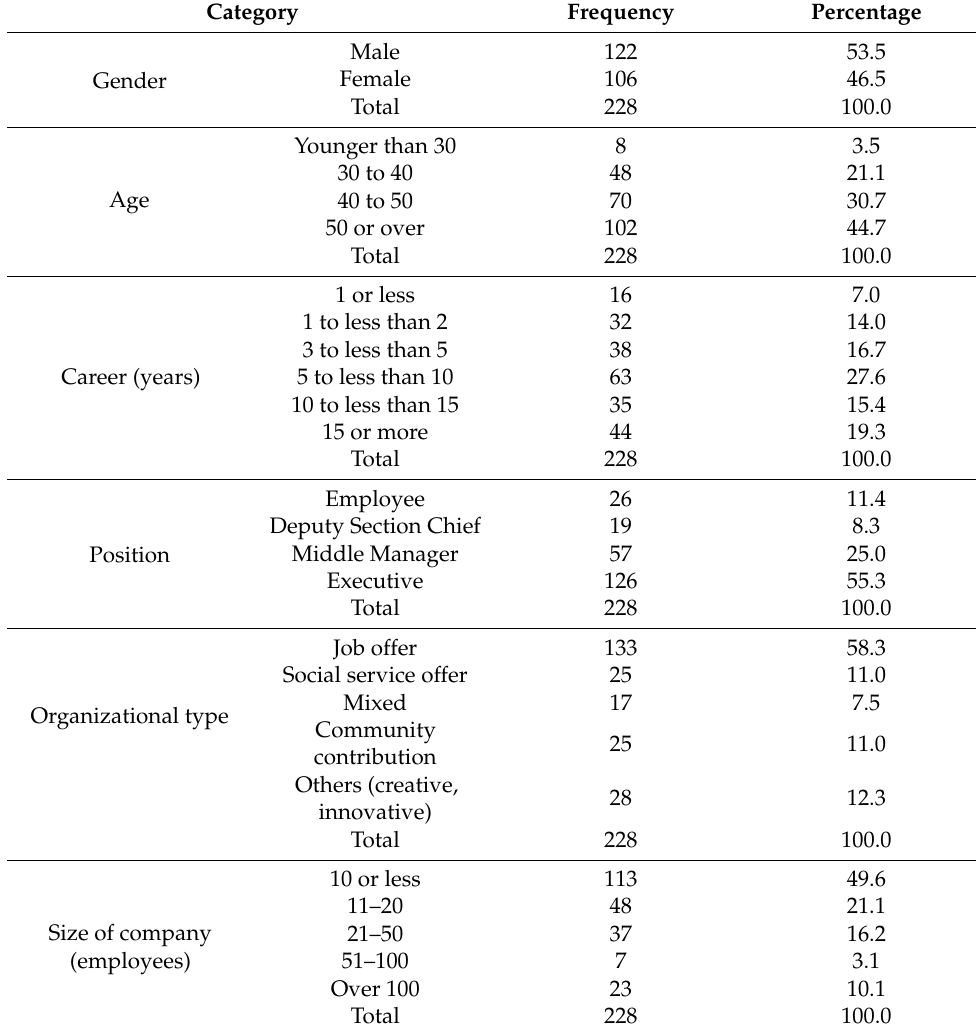
Table 2. Demographic information of survey